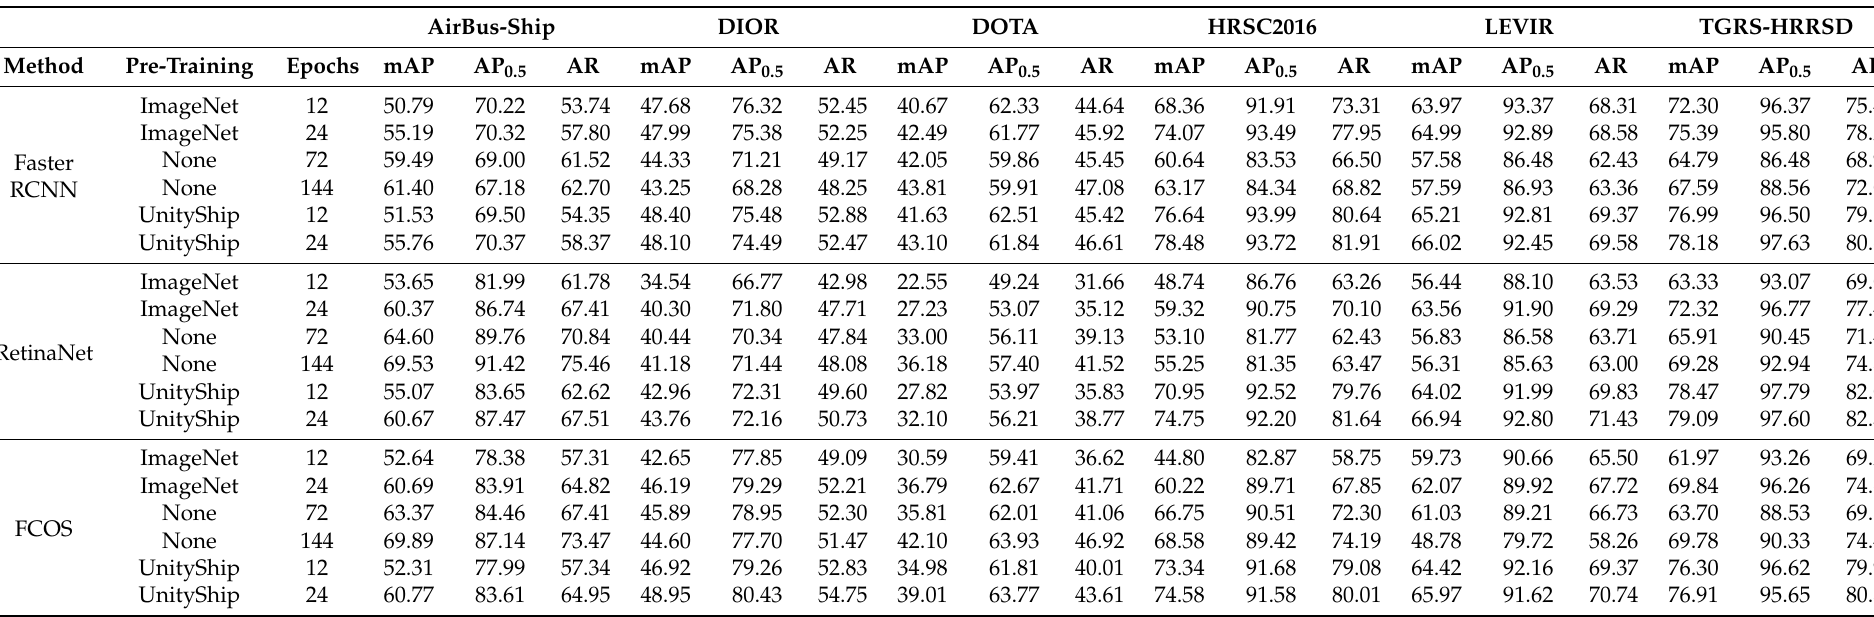
Table 5. Comparison of mAP, AP 0.5 , and AR for different datasets with different model-pretraining settings and different training